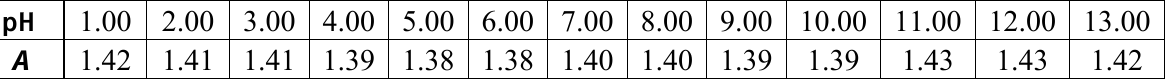
Table 2. Absorbance of CoASH at 258 nm, c =10 -4 M in wide pH range.